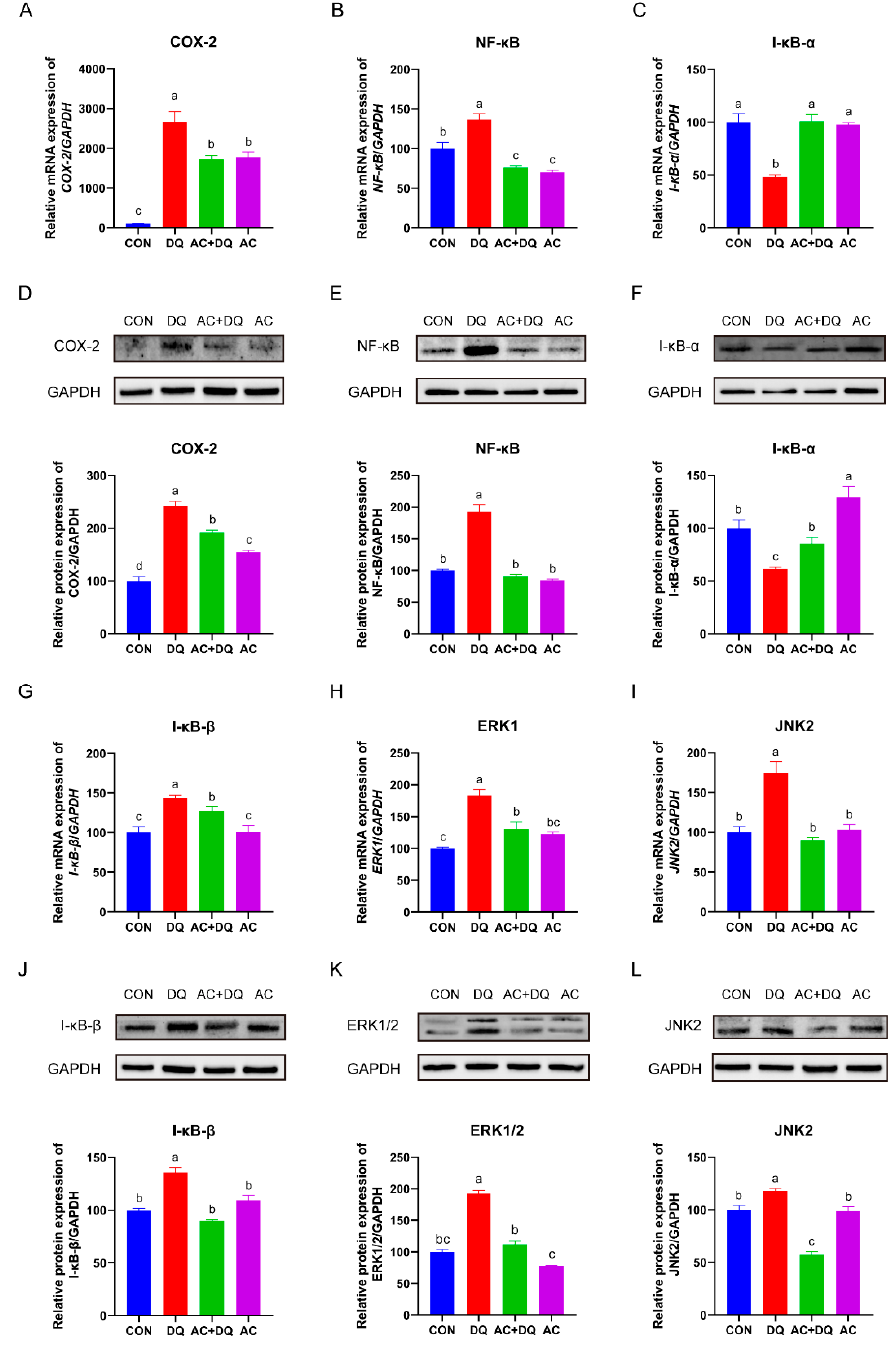
Figure 7. Effects of acidifiers on the NF- κ B/MAPK/COX-2 signaling pathways in IPEC-J2 cells. The mRNA levels of COX-2 ( A ), NF- κ B ( B ), and I- κ B- α ( C ). The protein expression level of COX-2 ( D ), NF- κ B ( E ), and I- κ B- α ( F ). The mRNA levels of I- κ B- β ( G ), ERK1 ( H ), and JNK2 ( I ). The protein expression level of I- κ B- β ( J ), ERK1/2 ( K ), and JNK2 ( L ). CON, cells without being treated; DQ, cells were only treated by 1150 µ M of diquat for 6 h; AC + DQ, cells were pretreated by 0.005% acidifier for 4 h and were then treated by 1150 µ M of diquat for 6 h. AC, cells were only treated by 1150 µ M of acidifier for 6 h. All values were represented as means ± SEM ( n = 3). Different superscript letters denote a statistically significant difference between groups ( p < 0.05), while same letters denote no significant